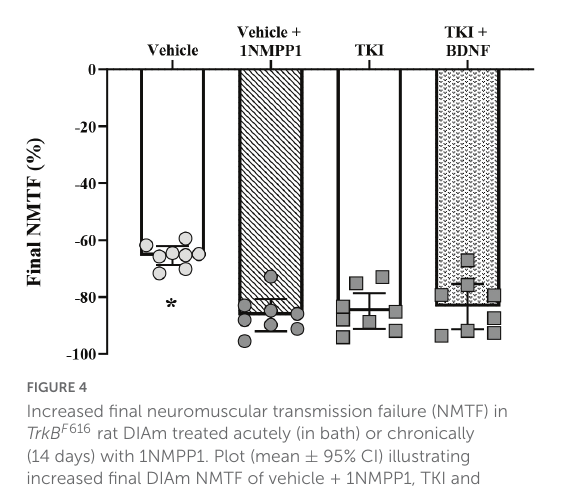
FIGURE4 Increased final neuromuscular transmission failure (NMTF) in TrkB F 616 rat DIAm treated acutely (in bath) or chronically (14 days) with 1NMPP1. Plot (mean ± 95% CI) illustrating increased final DIAm NMTF of vehicle + 1NMPP1, TKI and TKI + BDNF compared to vehicle rats (one-way ANOVA,